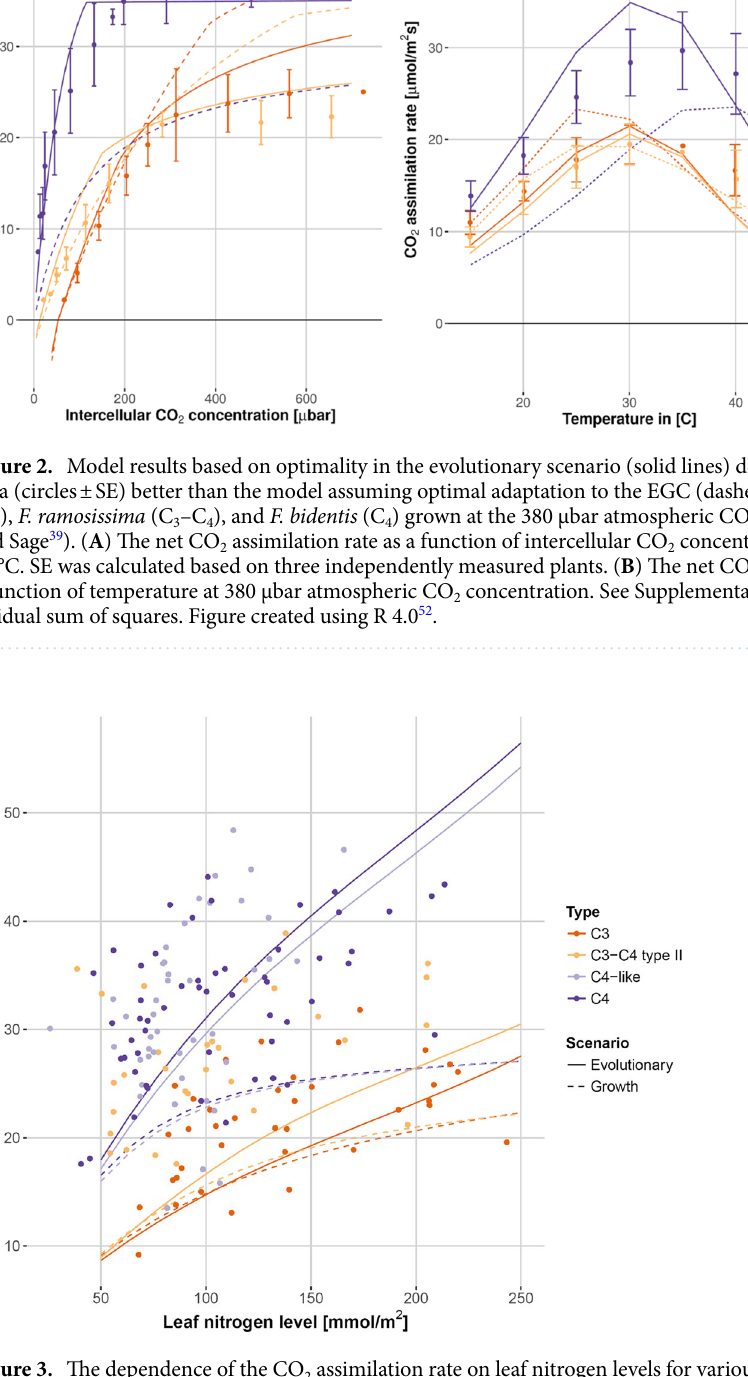
Figure 3. The dependence of the CO 2 assimilation rate on leaf nitrogen levels for various Flaveria species is consistent with model results based on optimality in the evolutionary scenario (solid lines). For C 3 -C 4 intermediate, C 4 -like, and C 4 , these results outperform results from simulations assuming optimal phenotypic adaptation to the EGC (dashed lines). The modeled species are F. pringlei (C 3 ) , F. floridana (C 3 -C 4 ) , F. palmeri (C 4 -like) , and F. bidentis (C 4 ) (data from Vogan and Sage 30 ). See Supplementary Table S9 for the residual sum of squares. Figure created using R 4.0 52